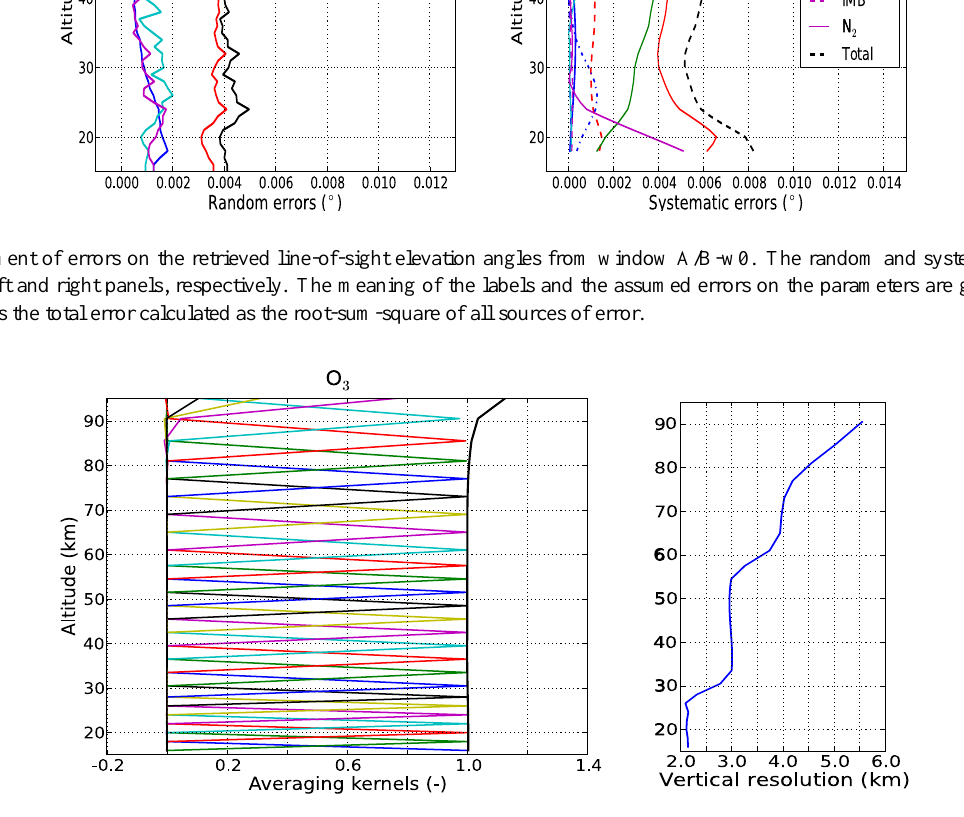
species and a priori and covariance matrices are the same as for process w0. The averaging kernels analysis shows that the O 3 profile can be retrieved from 18 to 90 km with a ver- tical resolution close to the retrieval grid sampling (Fig.